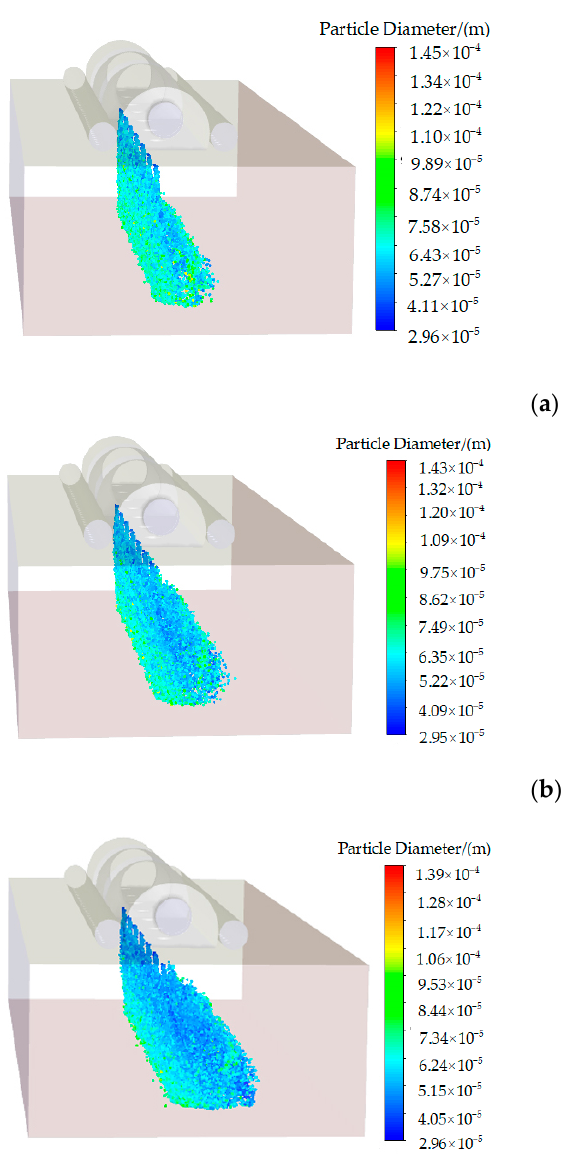
( b ) Figure 10. Droplet spatial distribution with different crosswind speed: 2 m/s ( a ); 4 m/s ( b ). As shown in Figure 10, when the crosswind wind speed is 4 m/s, the droplets had obvious lateral drift. Additionally, the smaller the droplet diameter is, the further the lateral drifting distance is. The angle between the drifting profile and the droplet concentration calibration line was defined as β . When the crosswind speed is 2 m/s, β is about 21°. However, when the crosswind wind speed is 4 m/s, β is about 31°, which indicates that the droplet drift is serious. Therefore, it is not suitable for spraying when the natural wind speed is higher. 3.2.2. Simulation of the Influence of Different Factors on Droplets Deposition According to the droplet’s spatial distribution, the droplet concentration in the calibration line was obtained by the fluent post-processing. The maximum concentration point was regarded as the droplet deposition center. Therefore, the influences on droplet deposition were analyzed by comparing the drifting distance of the droplet’s deposition center.